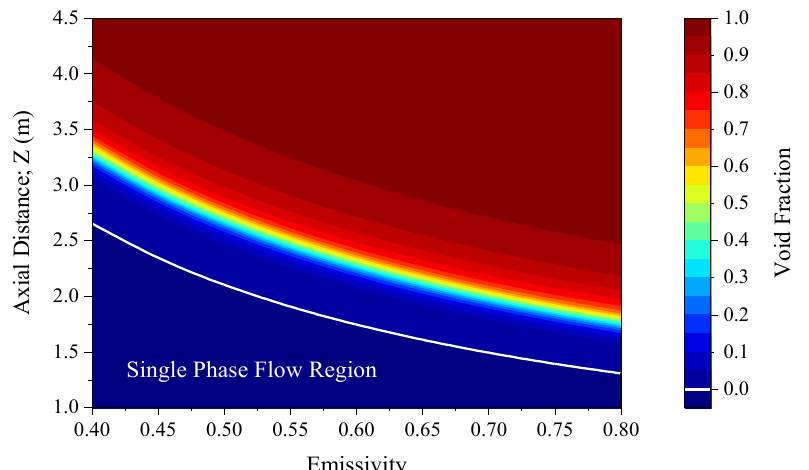
Figure 7. Void fraction distribution along the axial direction at inlet velocities from 0.3 m·s − 1 to 1.0 m·s − 1.